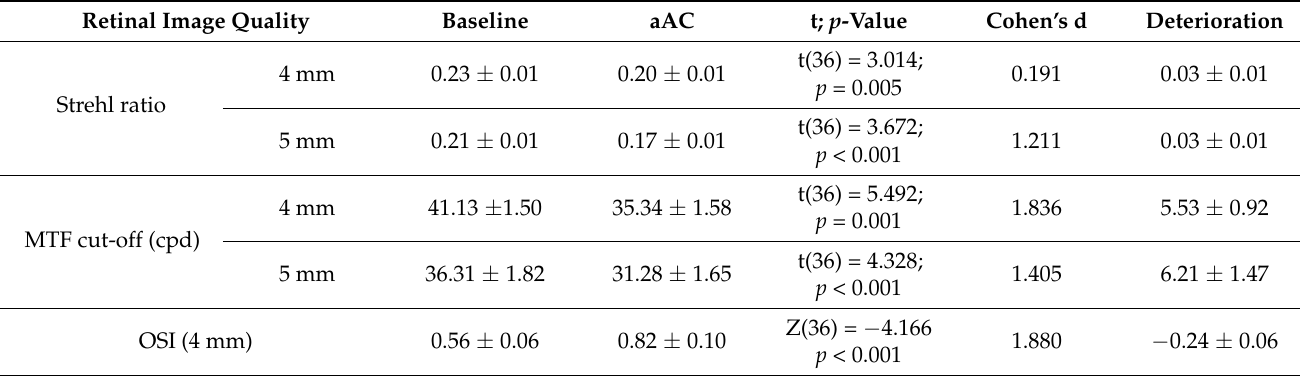
Table 2. Mean values of the retinal image quality parameters (Strehl ratio and MTF cut-off for both artificial pupil sizes of 4 and 5 mm, and the OSI parameter) and the corresponding deterioration under the two experimental conditions (baseline and aAC). Standard errors and statistical parameters are also